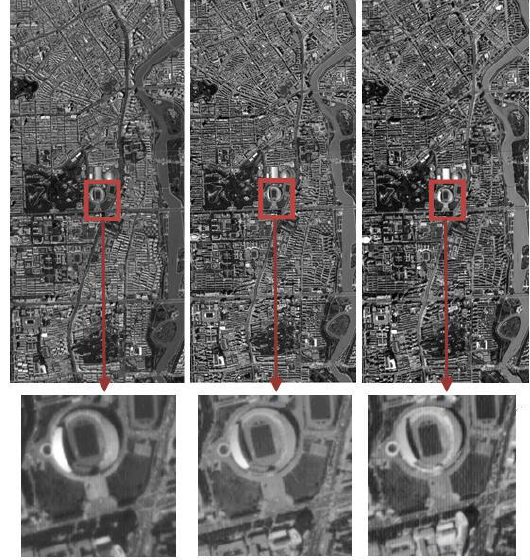
Figure 2. The three-line arrays image (Lift to right: forward, nadir and backward image)